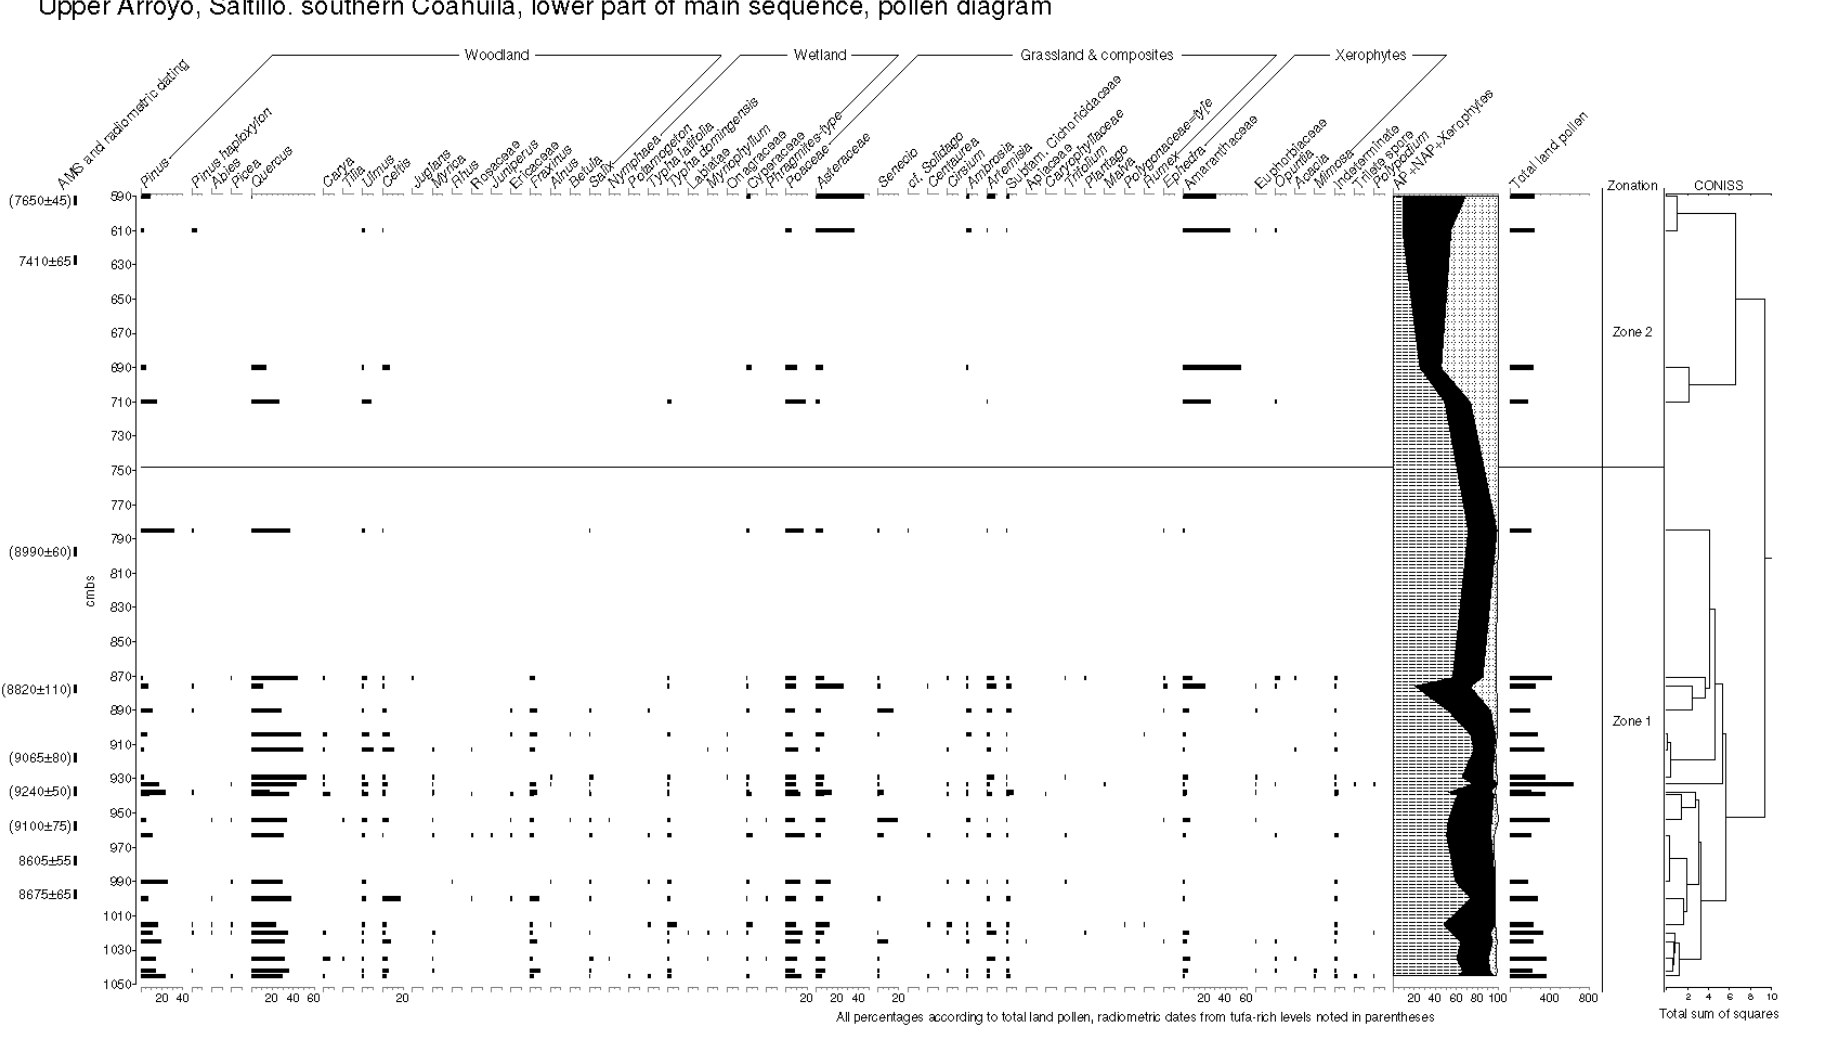
Figure 9. Relative pollen diagram for the Upper Arroyo main sequence, lower part.